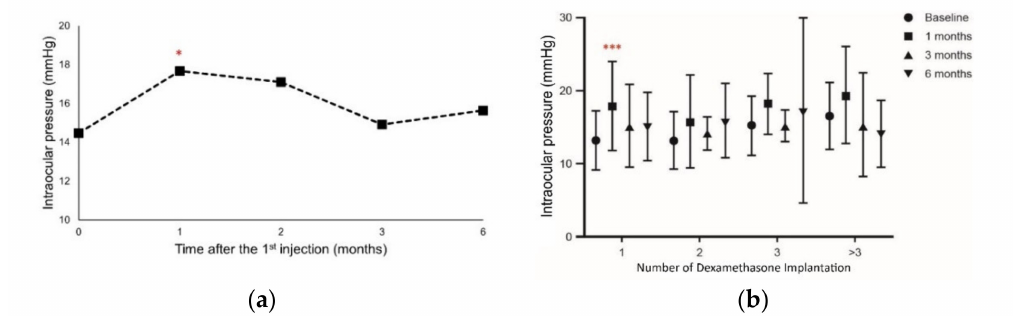
Figure 3. The change in intraocular pressure from baseline ( a ) after the 1st intravitreal dexamethasone implantation and ( b ) after the intravitreal dexamethasone implantation based on the number of implantations. Values represent mean ± SD. p < 0.05 were considered statistically different. * p < 0.05, *** p <